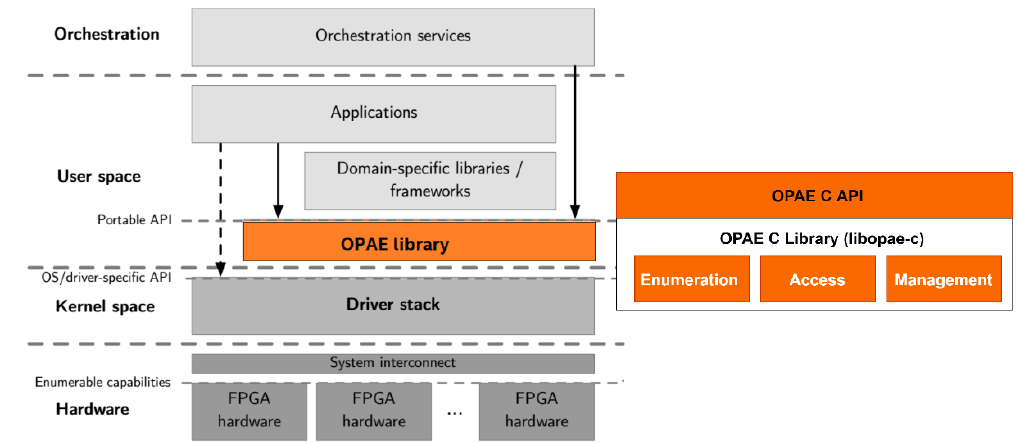
Figure 5. Open Programmable Acceleration Engine.